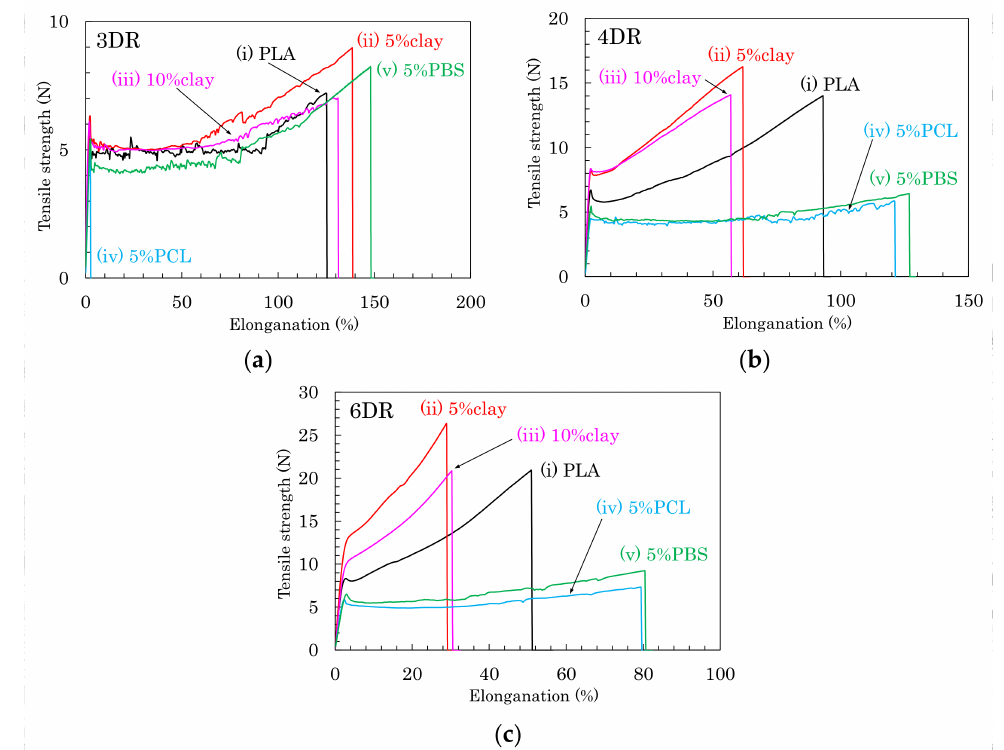
Figure 7. Stress-strain curves of PLA fibers formed using different draw ratios: ( a ) 3 DR; ( b ) 4 DR; ( c ) 6